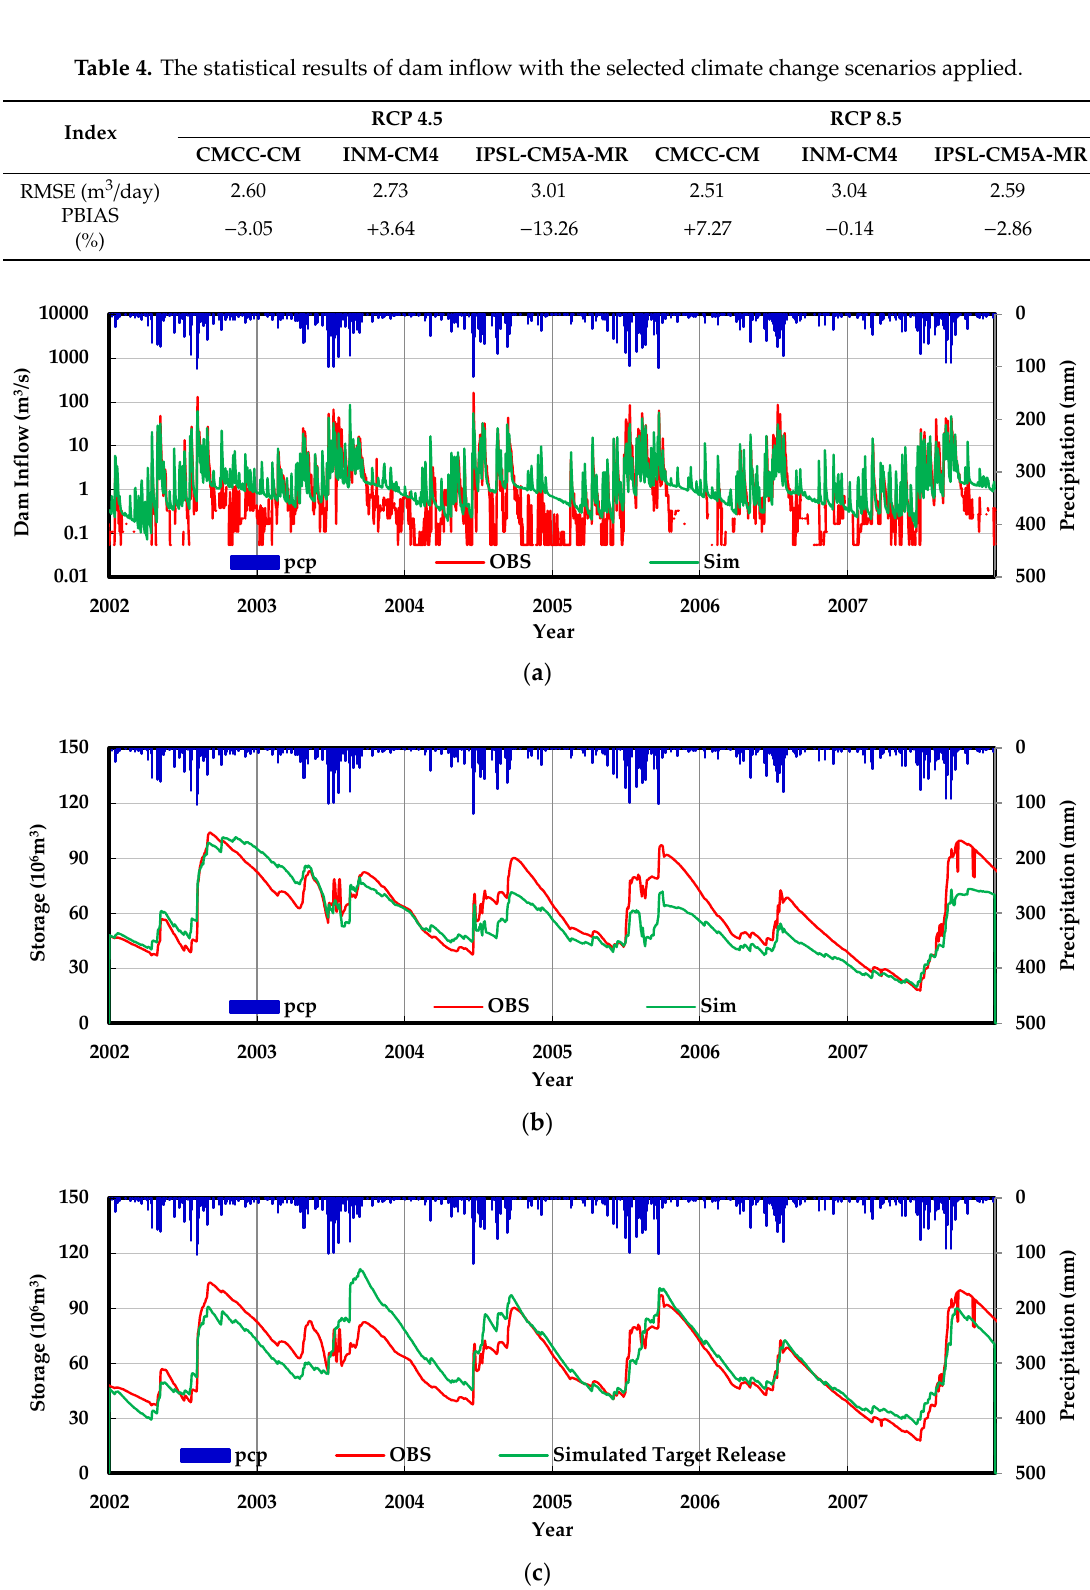
Figure 3. Comparison of daily observed and simulated dam inflow ( a ), dam storage using observed release data ( b ), and dam storage estimated by applying the monthly target release ( c